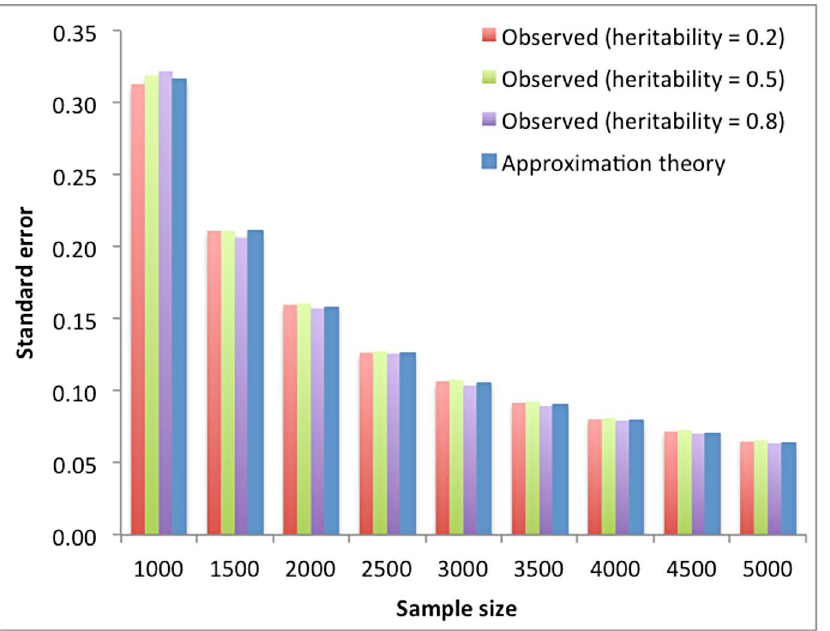
Figure 1. Standard error of the estimate of variance explained by all SNPs vs. sample size. The first three columns are the averaged standard error observed from 100 simulations under three heritability levels. The last column is the predicted standard error from our approximation theory. The plotted data can be found in Table S1.